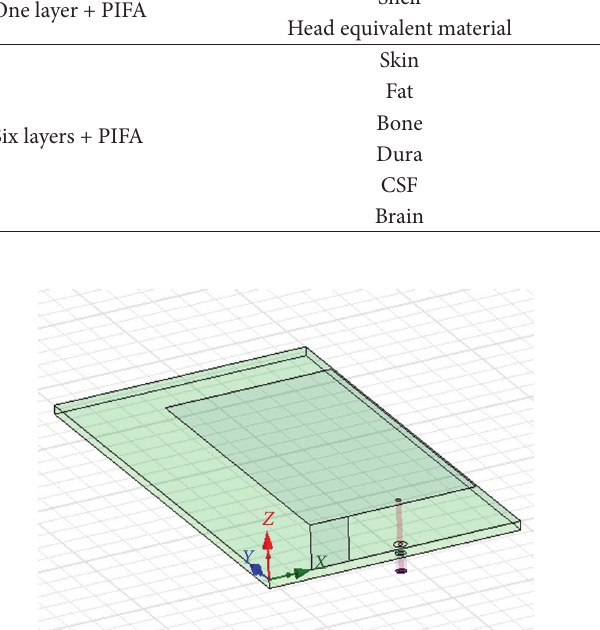
T 7: Compression between SAR in two models (one- and six-layer model by PIFA antenna). Max SAR (watt/Kg) Layer Conductivity Local SAR Average SAR One layer + PIFA